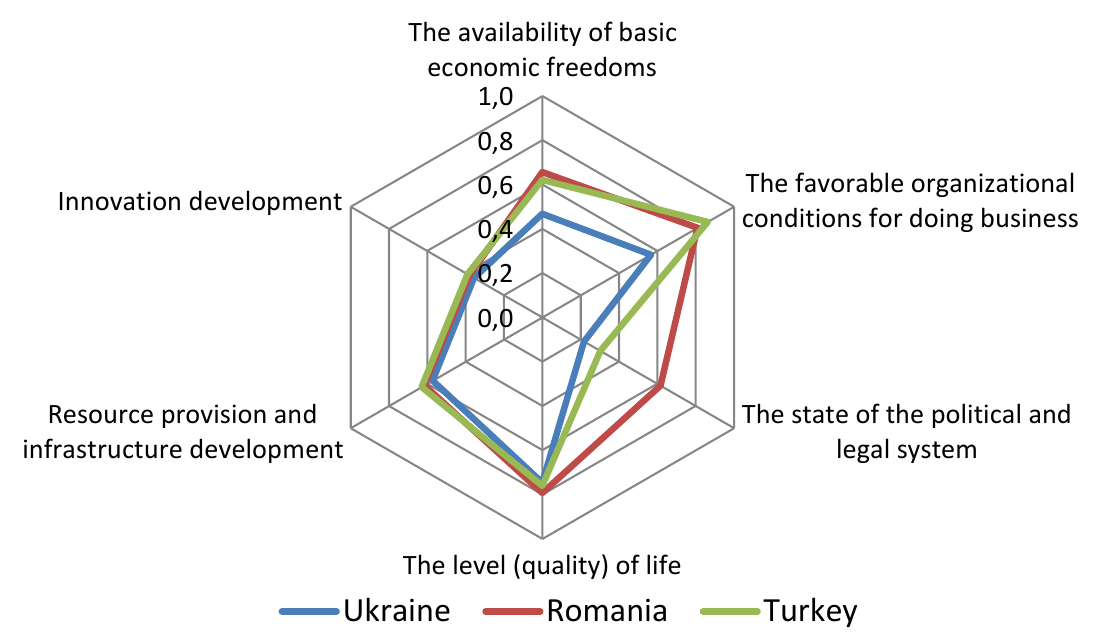
Figure 4. Business environment security in Ukraine and “countries-outsiders” in 2016